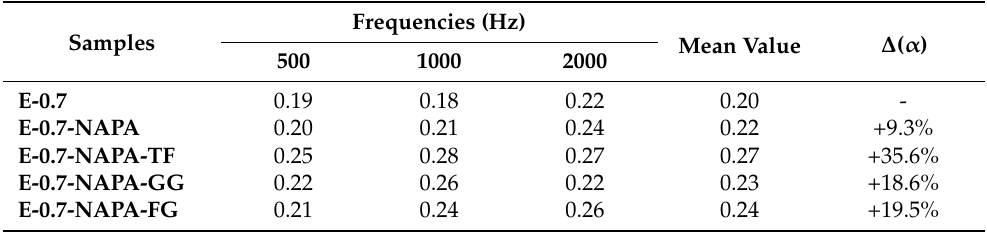
Table 9. Mean sound absorption coefficients.